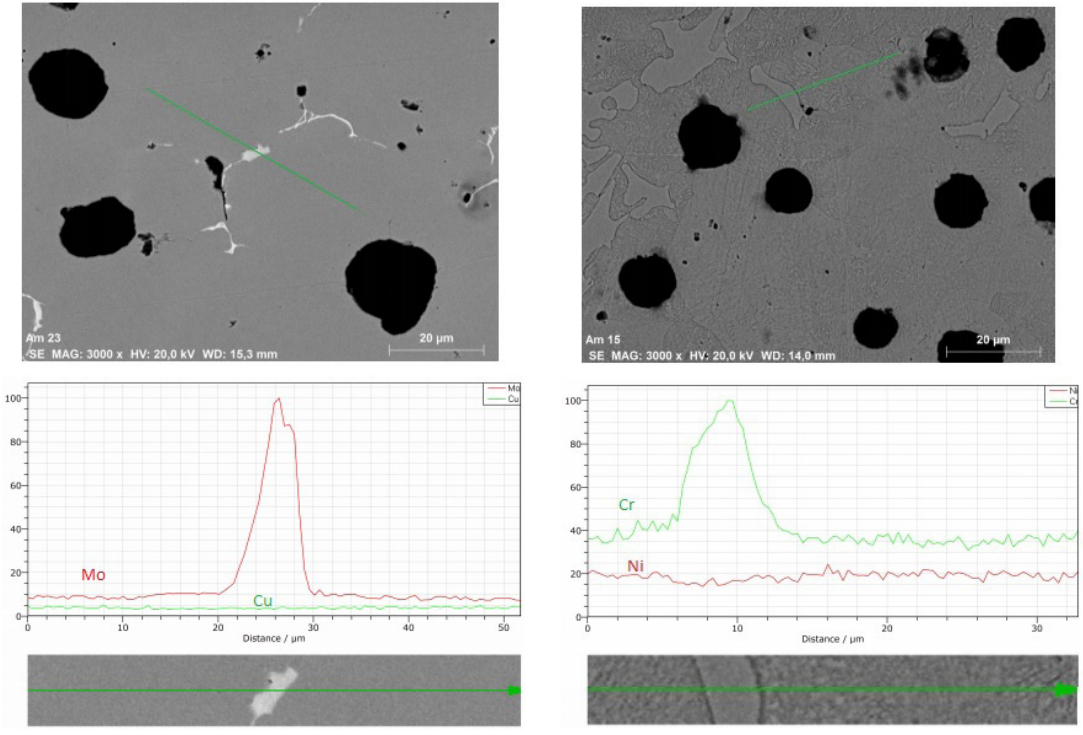
Figura 25. Ni/Cr EDS